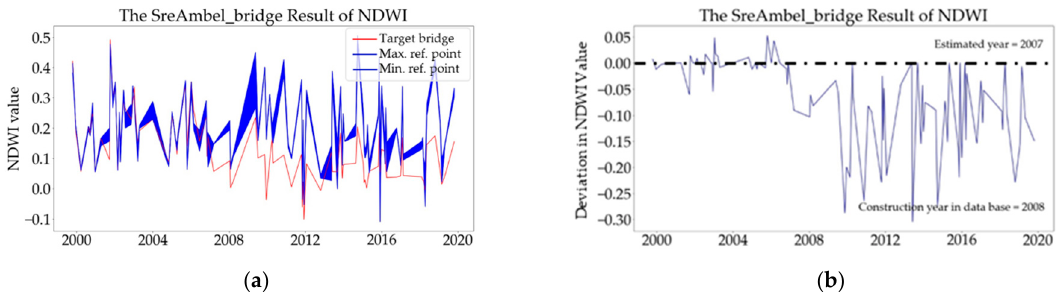
Figure 8. ( a ) Variation in NDWI index value at the target bridge (point) and reference points over time for the Sre Ambel Bridge; ( b ) re-visualization of ( a ) showing difference between NDWI of target and that of the closest reference